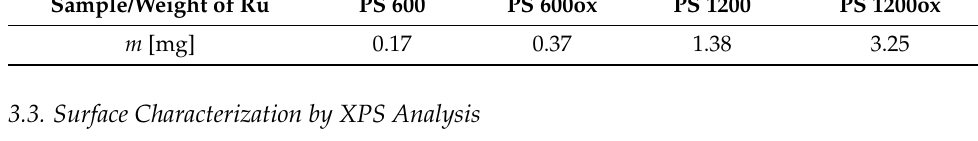
Table 3. The total calculated amount of deposited Ru by potentiostatic mode. Sample/Weight of